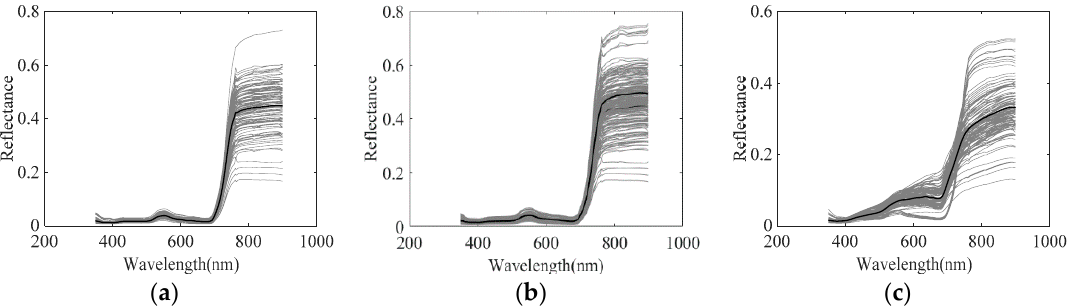
Figure 2. Spectral reflectance of the winter wheat canopy: ( a ) Jointing stage, ( b ) heading stage, and ( c ) grain-filling stage.